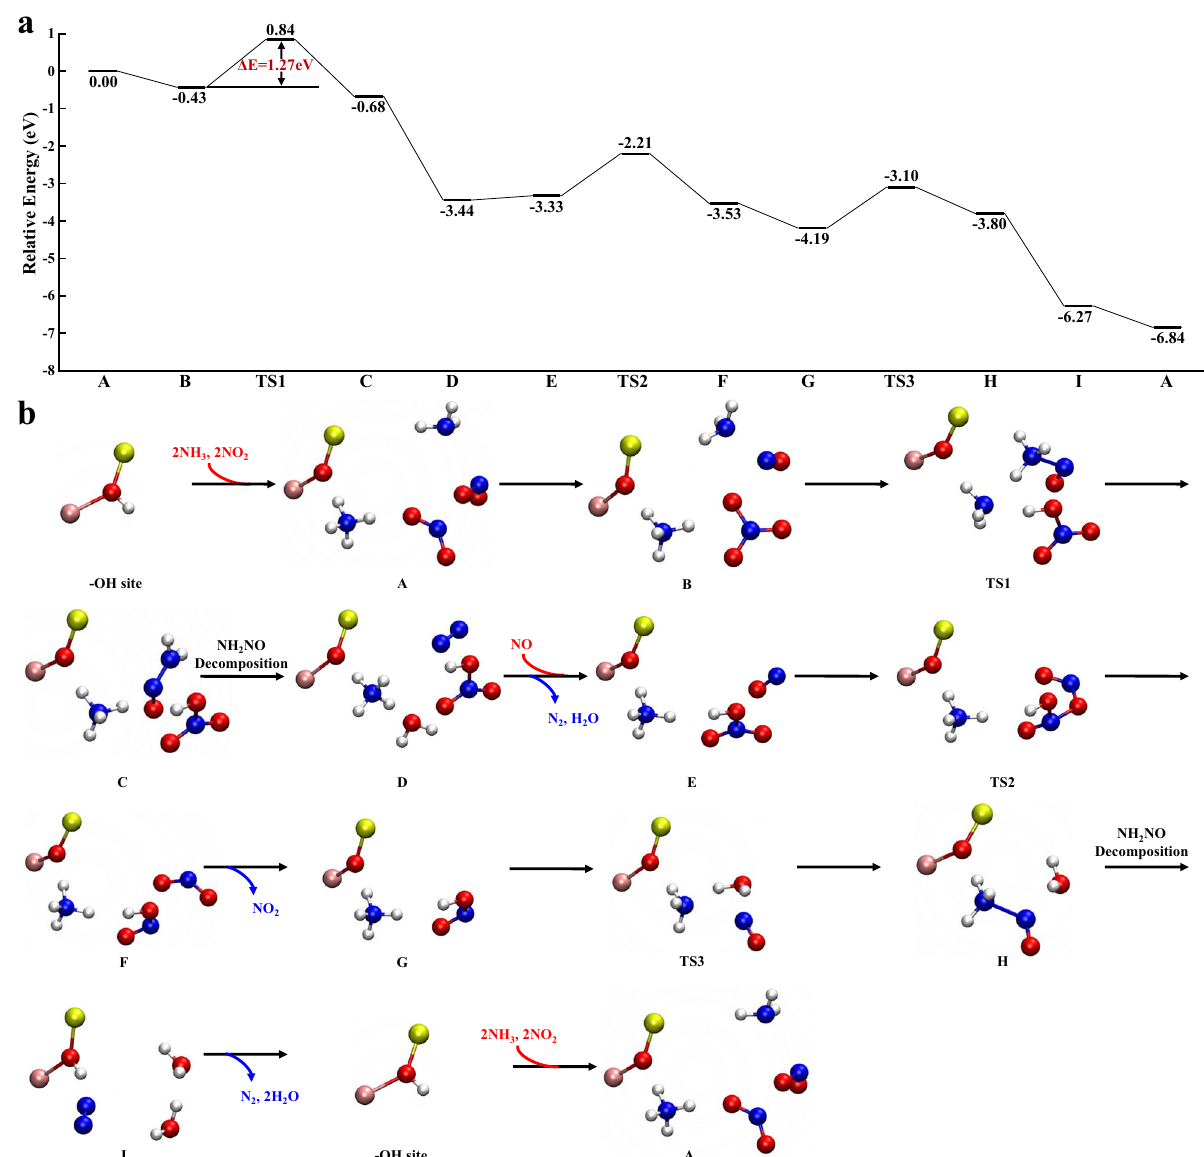
Fig.6|ReactionpathwayofthefastSCRcycleatBAS.a Gibbsfreeenergypro fi le. b Optimizedgeometriesofthereactants,TSsandproductsforallelementarysteps. ExceptfortheSiandAlatomslinkedtotheOHgroup,allotheratomsofthezeolite